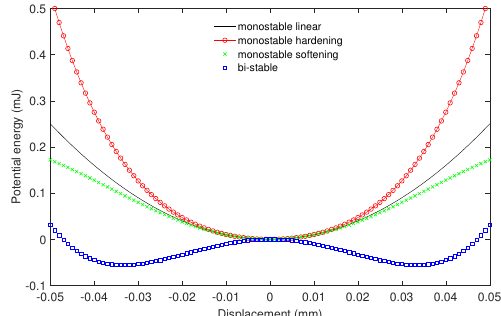
Figure 2. The potential energy function of the Duffing